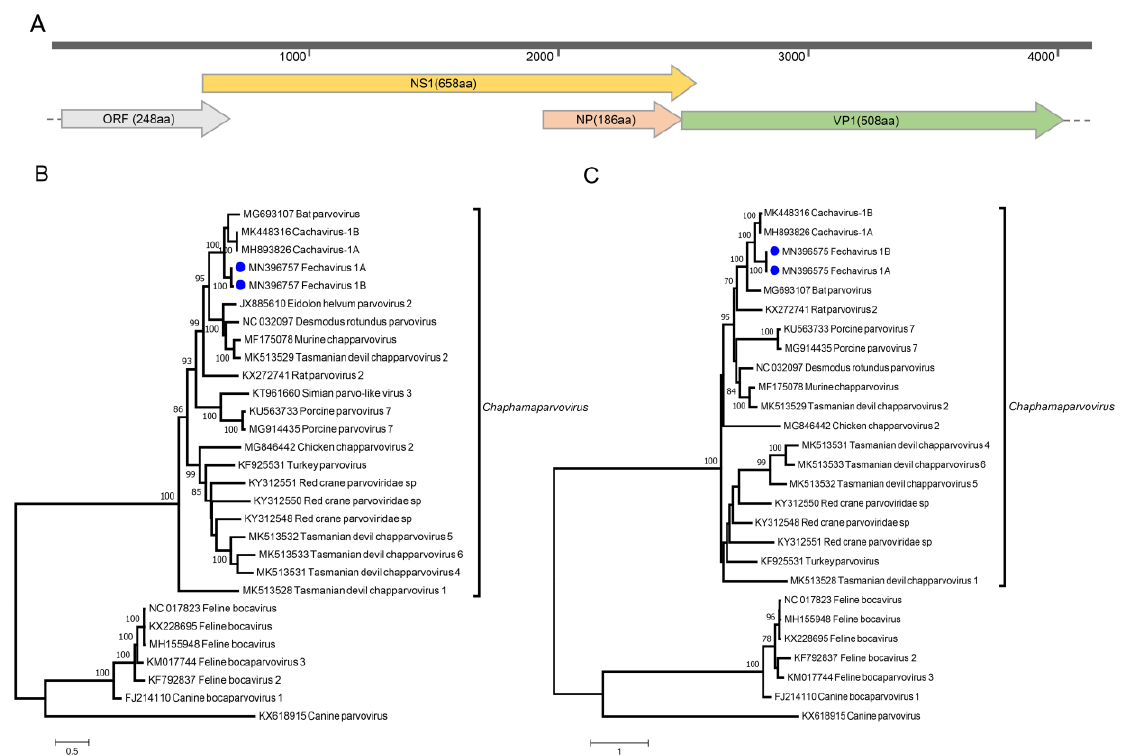
Figure 3. ( A ) Genome organization of fechavirus. Maximum-likelihood phylogenetic trees of NS1 protein sequences ( B ) and VP1 protein sequences ( C ). Fechaviruses found in this study were highlighted with blue cycles.